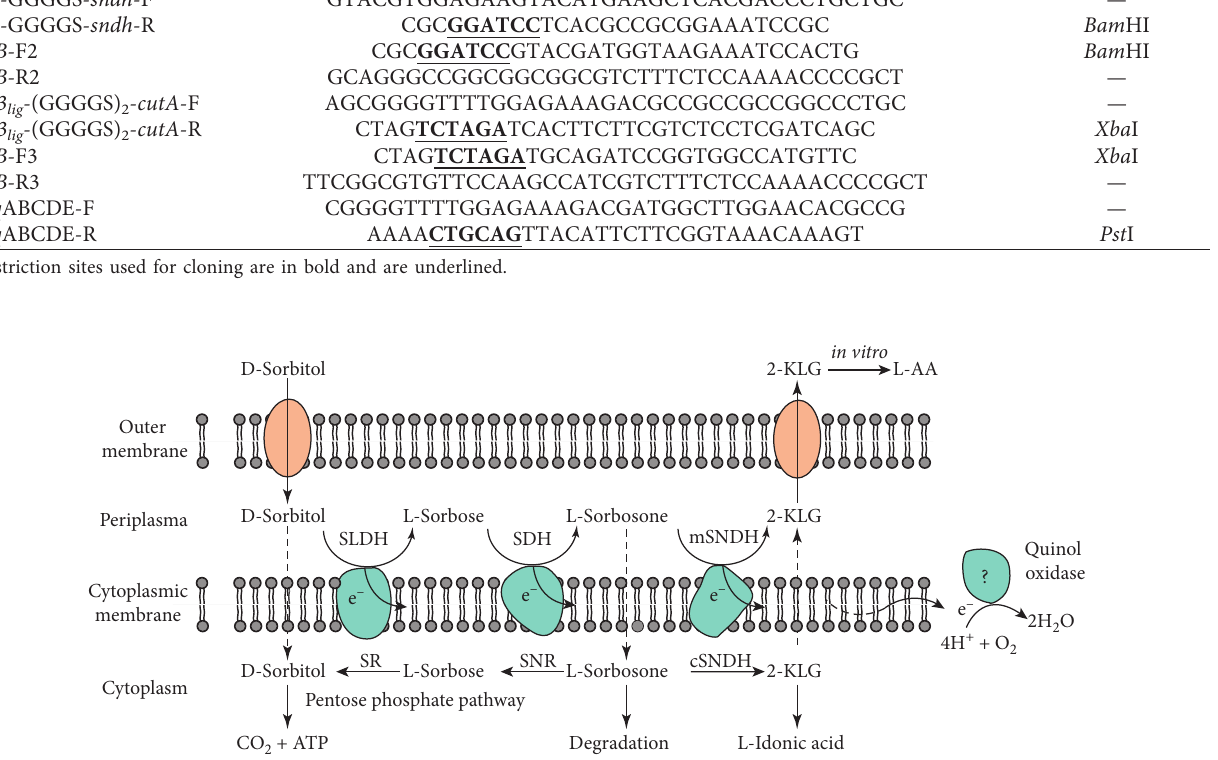
Figure 1: The metabolic pathway of D-sorbitol in the recombinant G. oxydans strains. SLDH, D-sorbitol dehydrogenase; SDH, L-sorbose dehydrogenase; SNDH, L-sorbosone dehydrogenase; mSNDH, membrane-bound SNDH; cSNDH, cytosolic SNDH; SR, L-sorbose re- ductase; SNR, L-sorbosone reductase.